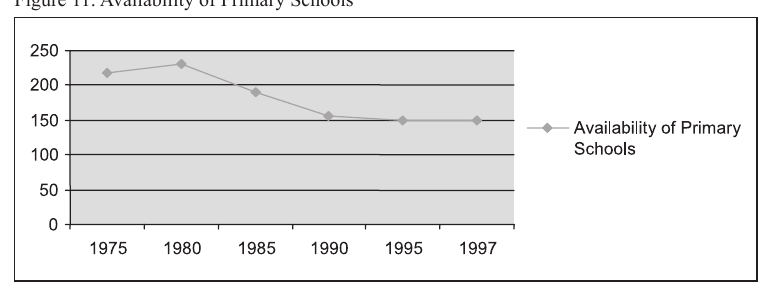
Figure 11. Availability of Primary